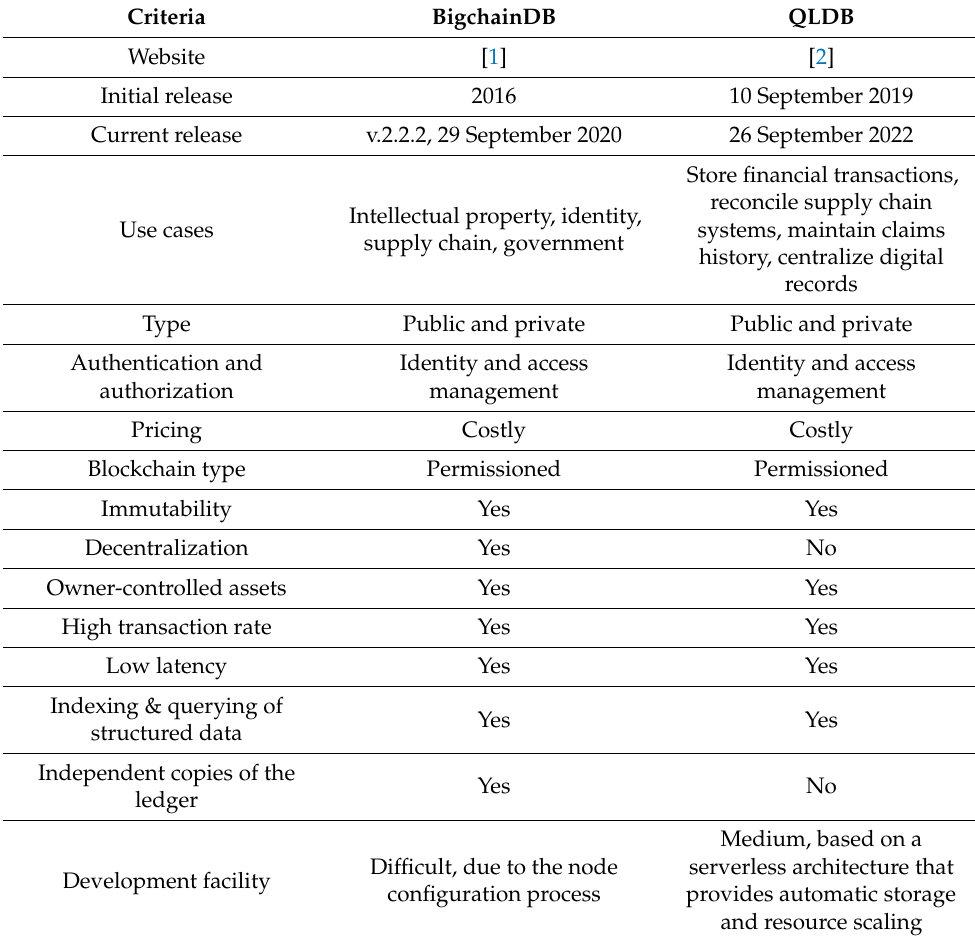
Table 6. Comparison of BigchainDB and QLDB [7,39–41]. Criteria